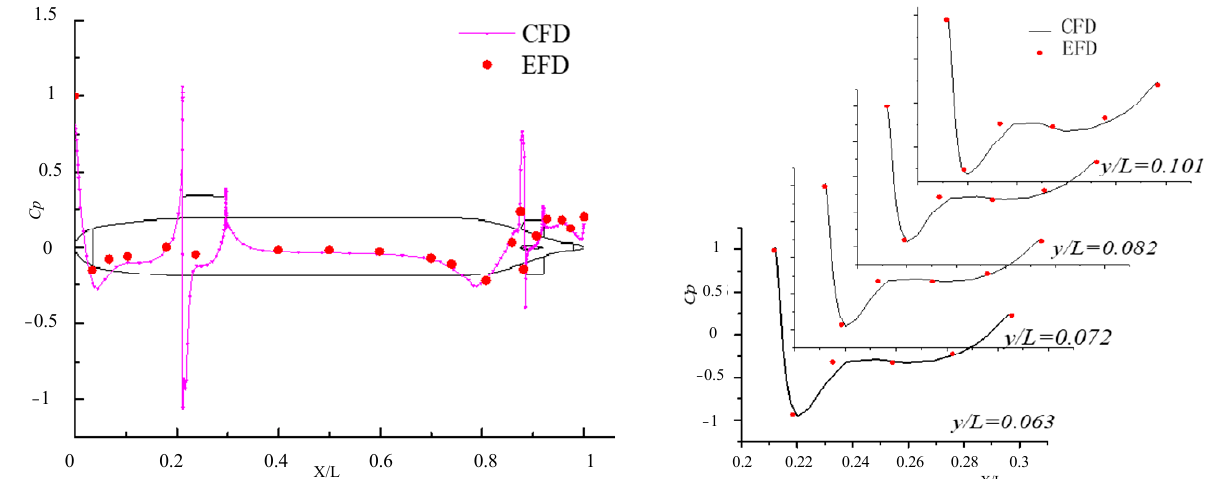
Figure 4. Comparison of pressure coe ffi cients on submarine surfaces.